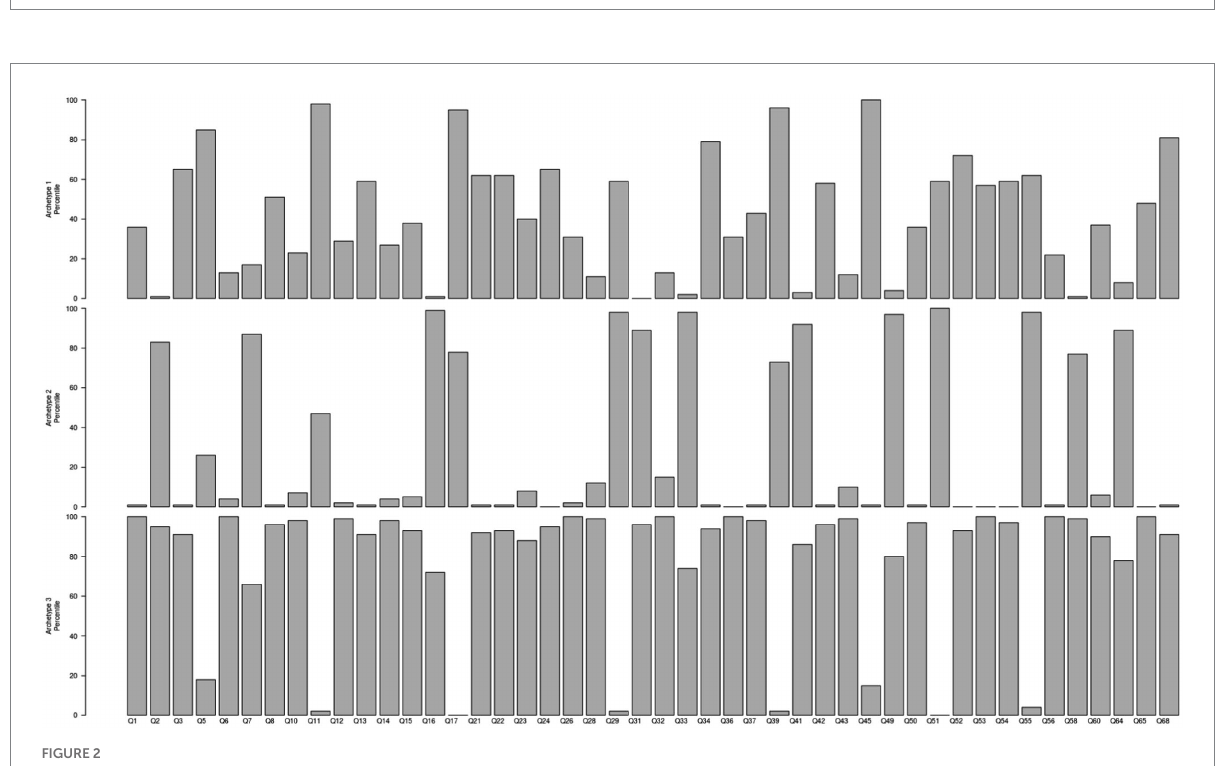
FIGURE 1 Screen plot of residual sum of squares.